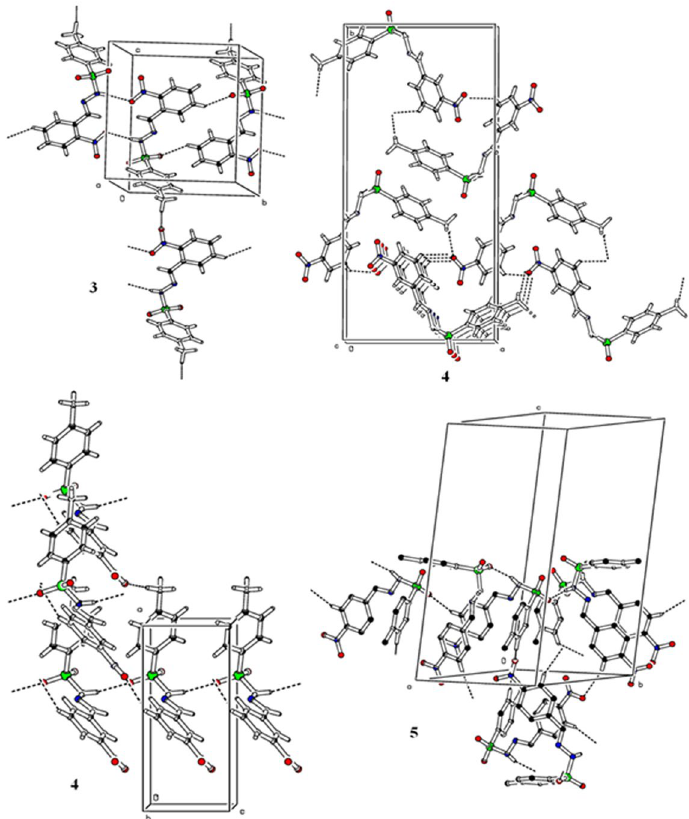
Figure 4. Hydrogen bonding pattern of the MNBBSH compounds.